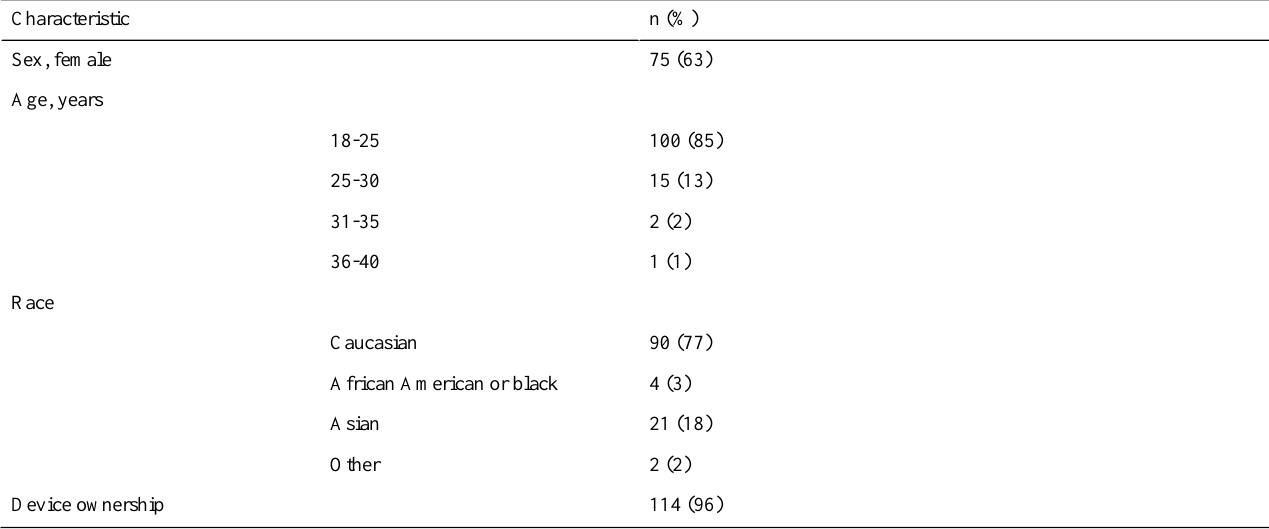
Table 2. Demographics (N=119).